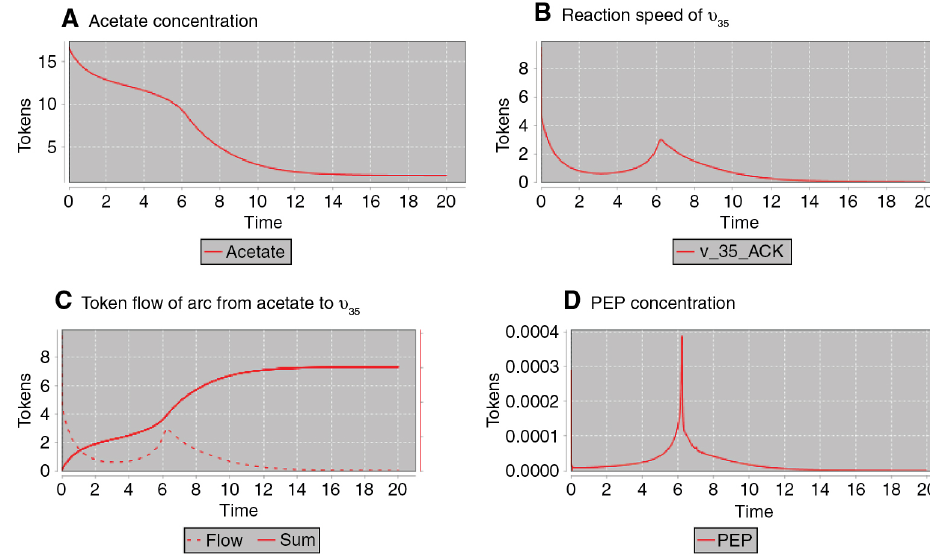
Figure 3: Simulation results of acetate, v